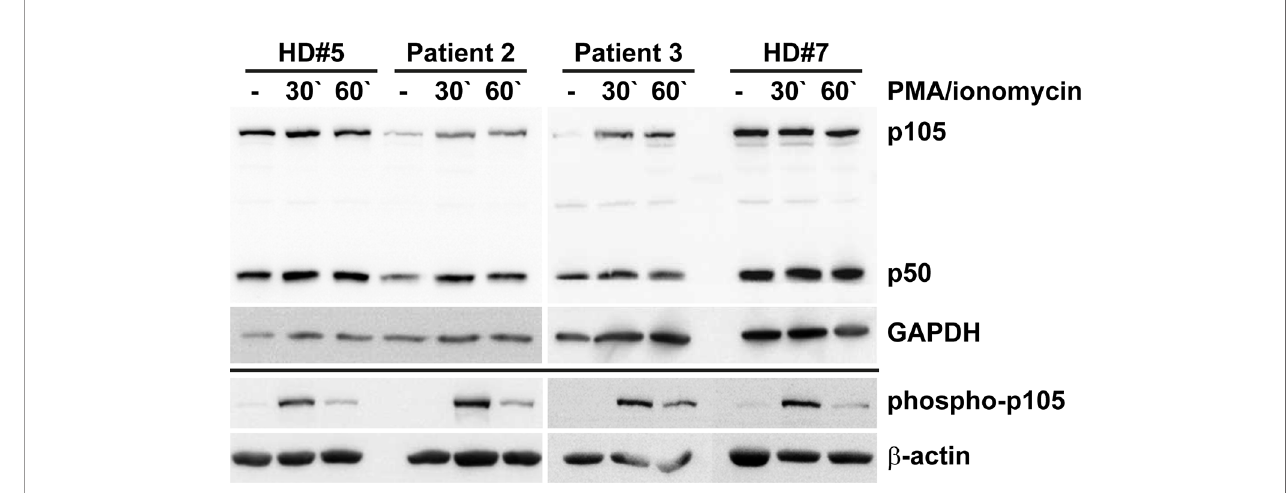
FIGURE 5 | Insuf fi ciency of p105 and p50 in heterozygous carriers of the NFKB1 missense variant c.1049A>G/p.Tyr350Cys. PBMCs derived from two affected family members (Patients 2 and 3) and two healthy volunteers (HD#5 and #7) were left untreated or treated with PMA/ionomycin for 30 or 60 minutes. Whole cell lysates were subjected to Western blotting using antibodies directed against the N-terminus of p105/p50 or against the phosphorylated form of p105. Anti-GAPDH and anti- b -actin antibodies were used as controls. Expression of p105 and p50 in cells carrying the heterozygous missense change p.Tyr350Cys only gains approximately half of the control levels. Whereas basal phospho-p105 is only detectable in healthy donor samples, a transient increase is observed in all panels. Expression analyses of p105 and p50 in EBV transformed B lymphocytes gained similar results and are shown in Supplementary Figure 3